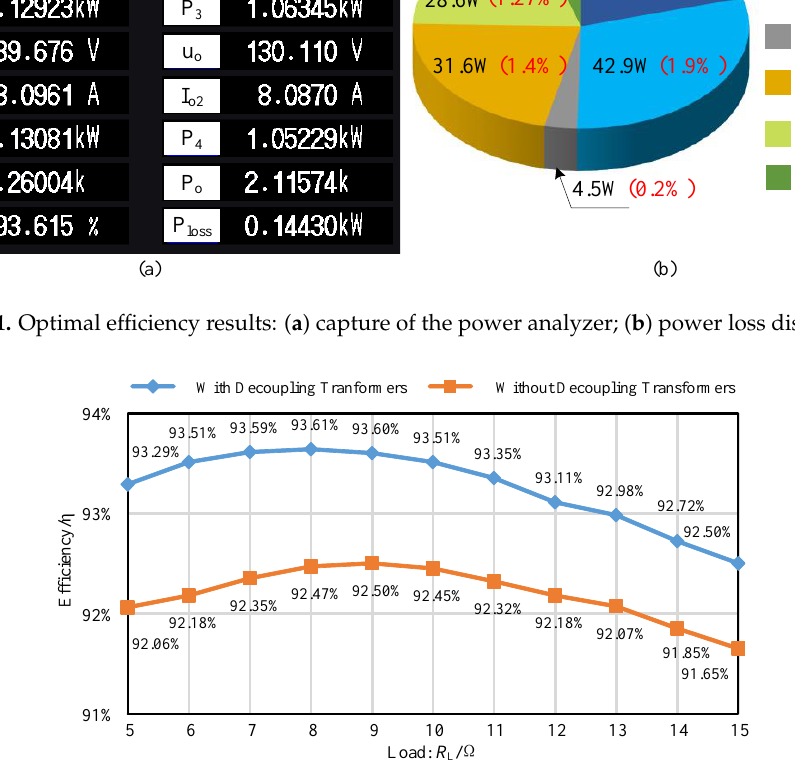
Figure 12. Measured overall efficiencies with various loads.